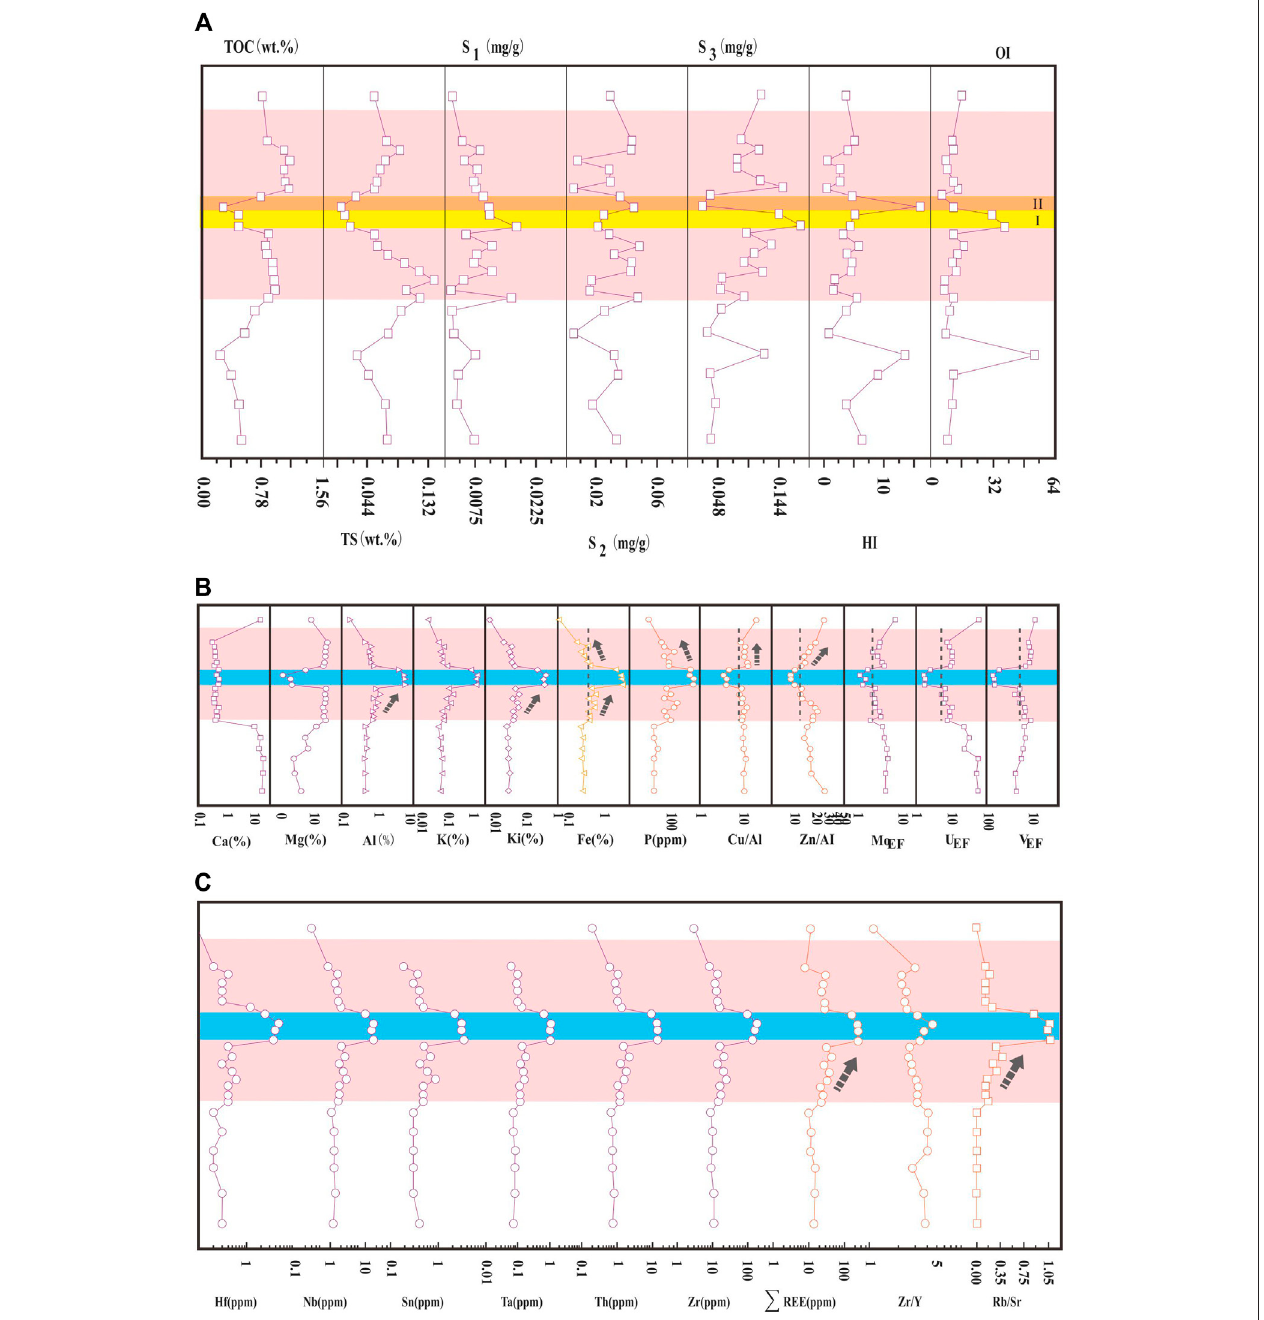
FIGURE3| Organic and inorganicgeochemistrycharactersfordifferentpartofthemicro section. (A) :Vertical distributions ofTOC,TS, S 1 ,S 2 ,S 3 ,HI,and OIinthe volcanic ash layer and upper and lower layers; (B) : Vertical distributions of major elements and other elements; (C) : Contents of immobile elements and vertical distributionsofZr/Yand Rb/Sr thelowest plain represents Lower Marl, theLower pink meansLower shaleand theblue beltfor volcanic ash.Theupper pinkisforUpper shale and the plain part in the top is for Upper Marl in Figure 1B .